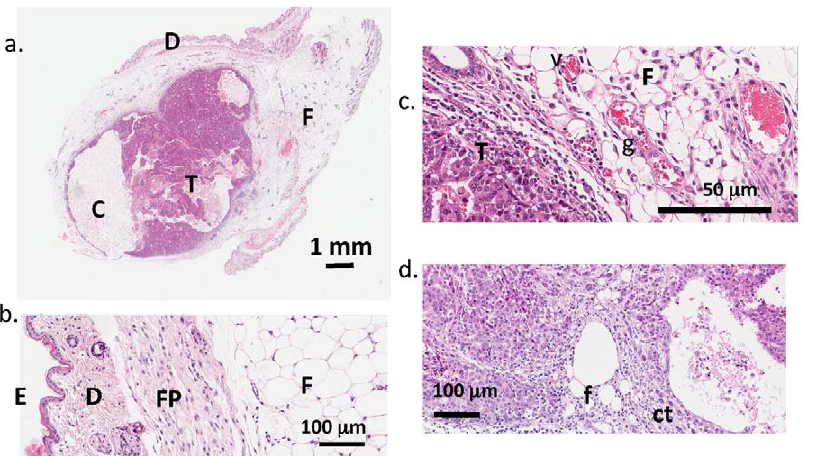
Figure 2. H&E stained histology of Met-1 tumors. H&E stained histology of MET-1 tumors. (a) H&E stained section of a single tumor ( T ) with multiple cysts ( C ) growing beneath the dermis ( D ) in the mammary fat pad ( F ). (b) The epidermis ( E ), dermis ( D ), fat pad fascia ( FP ) and fat ( F ) remote to the tumor has minimal inflammation. (c) In contrast, the fat pad ( F ) adjacent to the tumor ( T ) is inflamed with compressed adipocytes, dilated, engorged vessels ( V ) and scattered granulocytes ( g ). (d) The malignant nature of the tumor is illustrated by the cords of neoplastic cells infiltrating the adjacent fat ( f ) and connective tissue ( ct ).